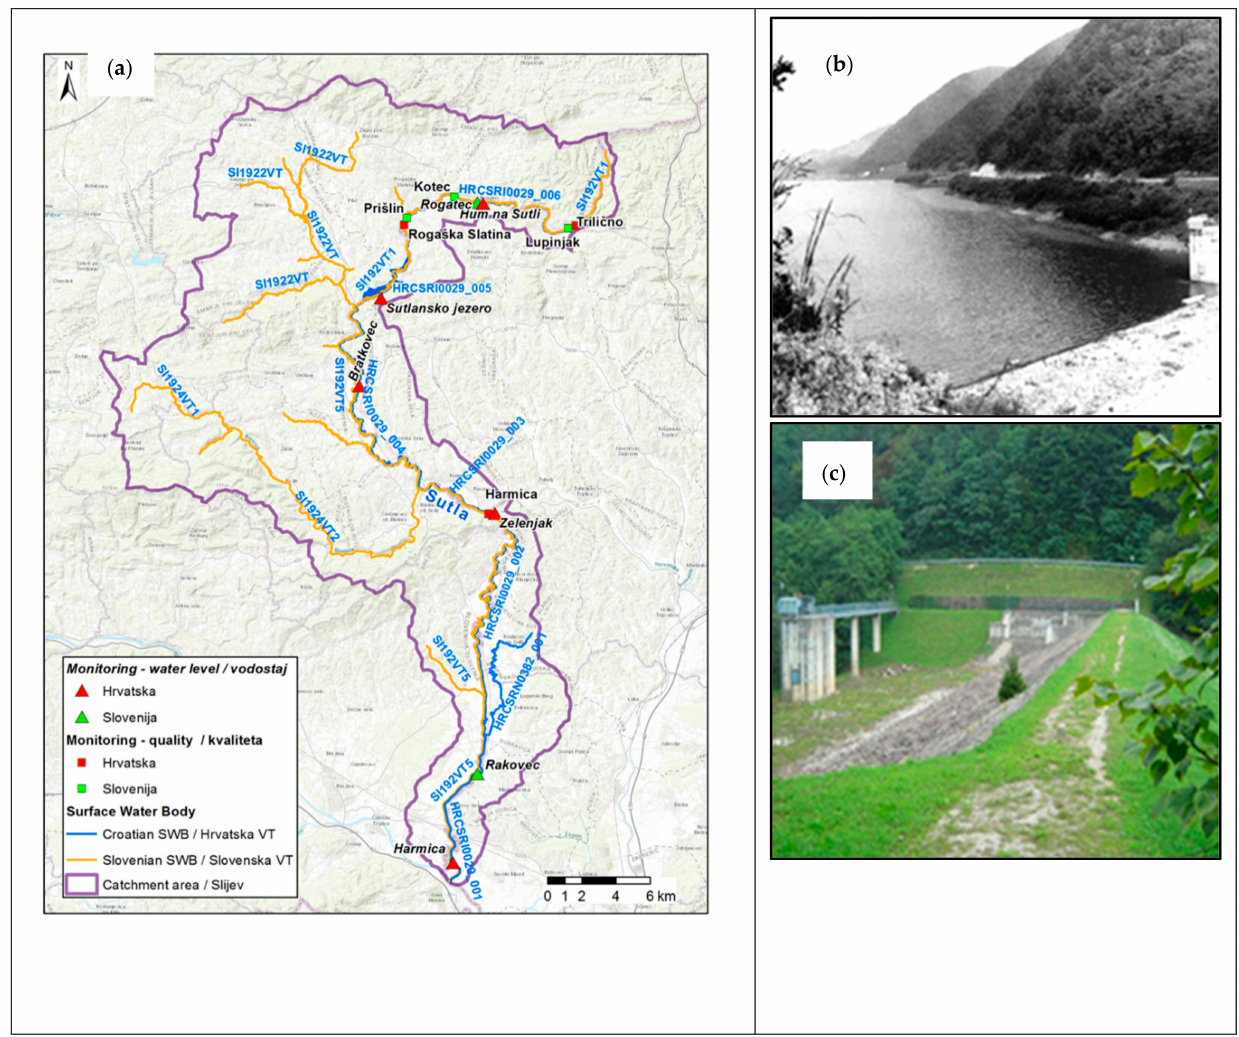
Figure 2. Transboundary Sutla river basin: ( a ) location of Sutla Lake, surface water bodies, and monitoring stations [18]; ( b ) Sutla Lake in the past [9]; ( c ) Sutla Lake in 2019